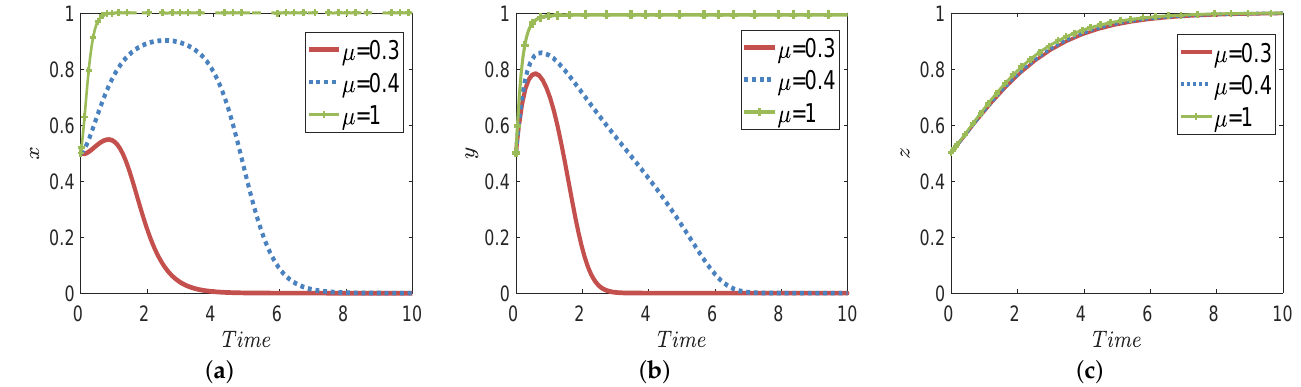
Figure 8. The impact of µ on evolution: ( a ) crowd workers; ( b ) crowdsourcing platforms; ( c ) task requesters.